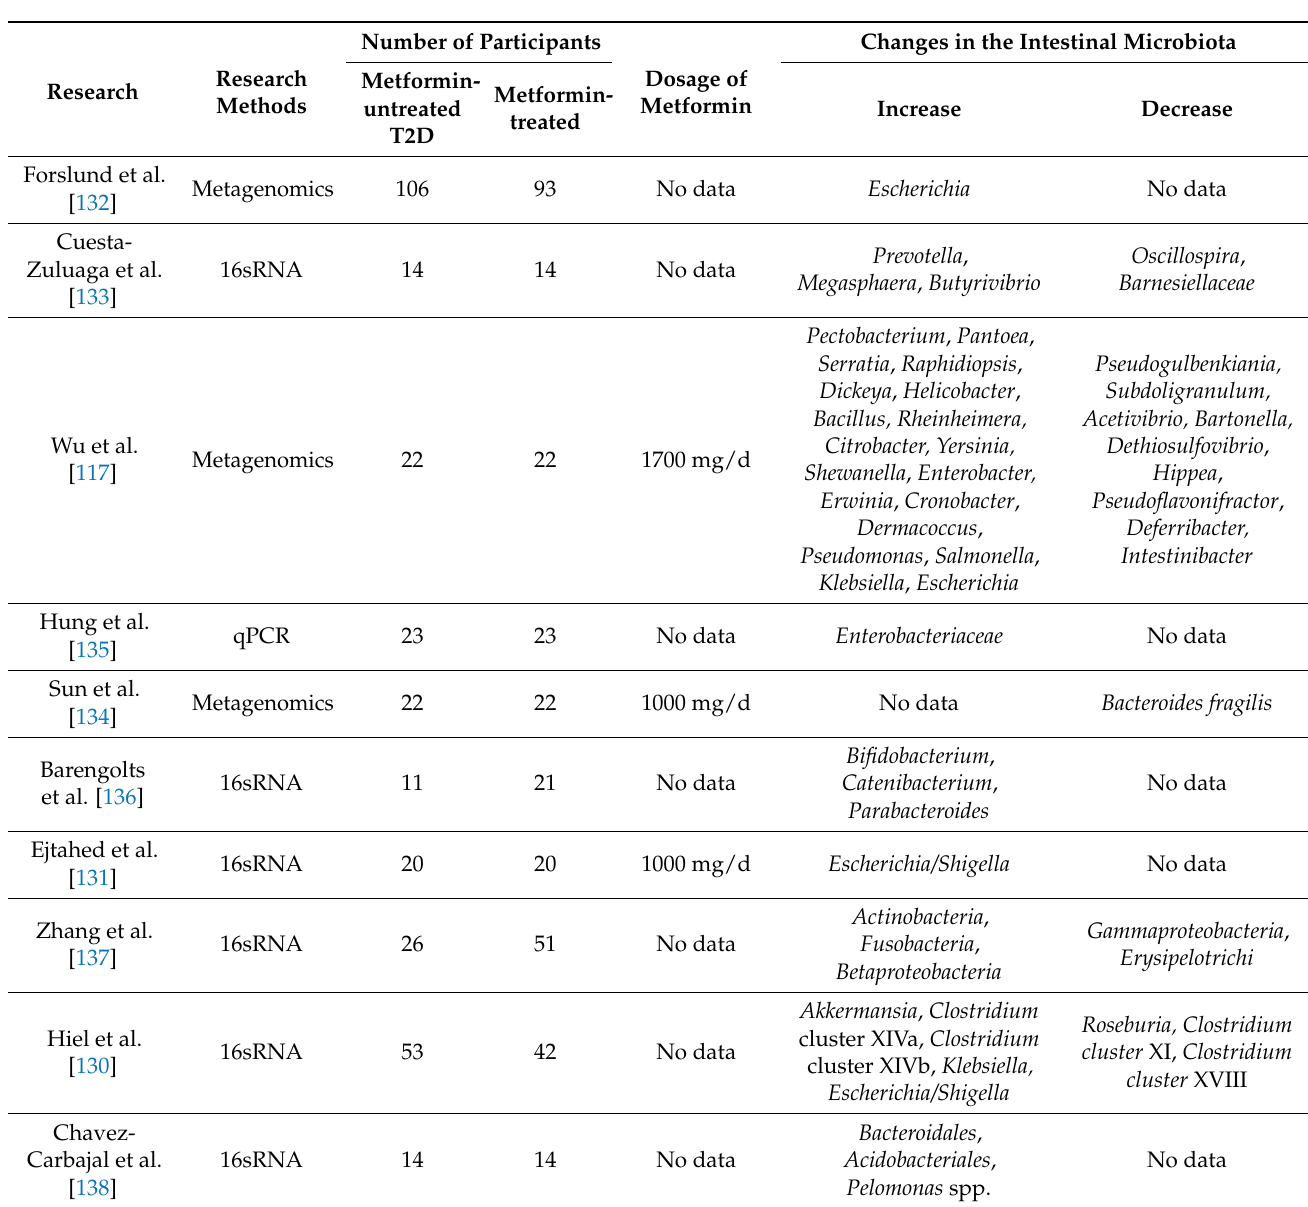
Table 3. Gut microbiota in patients with T2D receiving